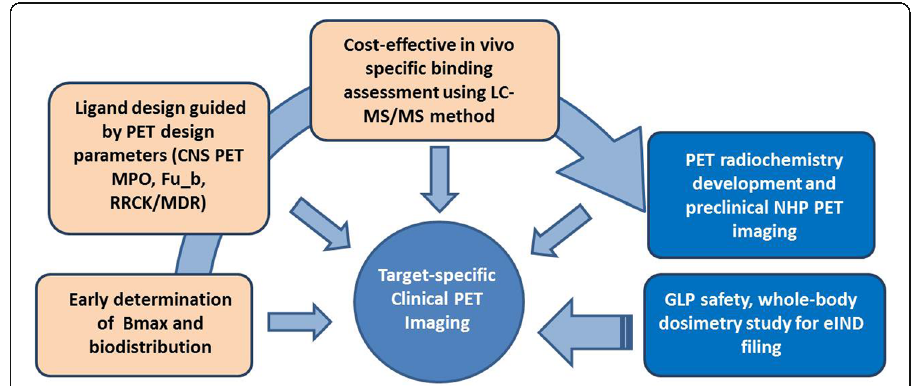
Fig. 8 A cost-effective novel CNS PET ligand discovery